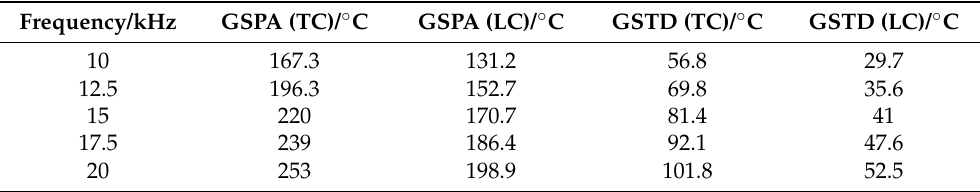
Figure 8. Effect of current frequency on temperature distribution.